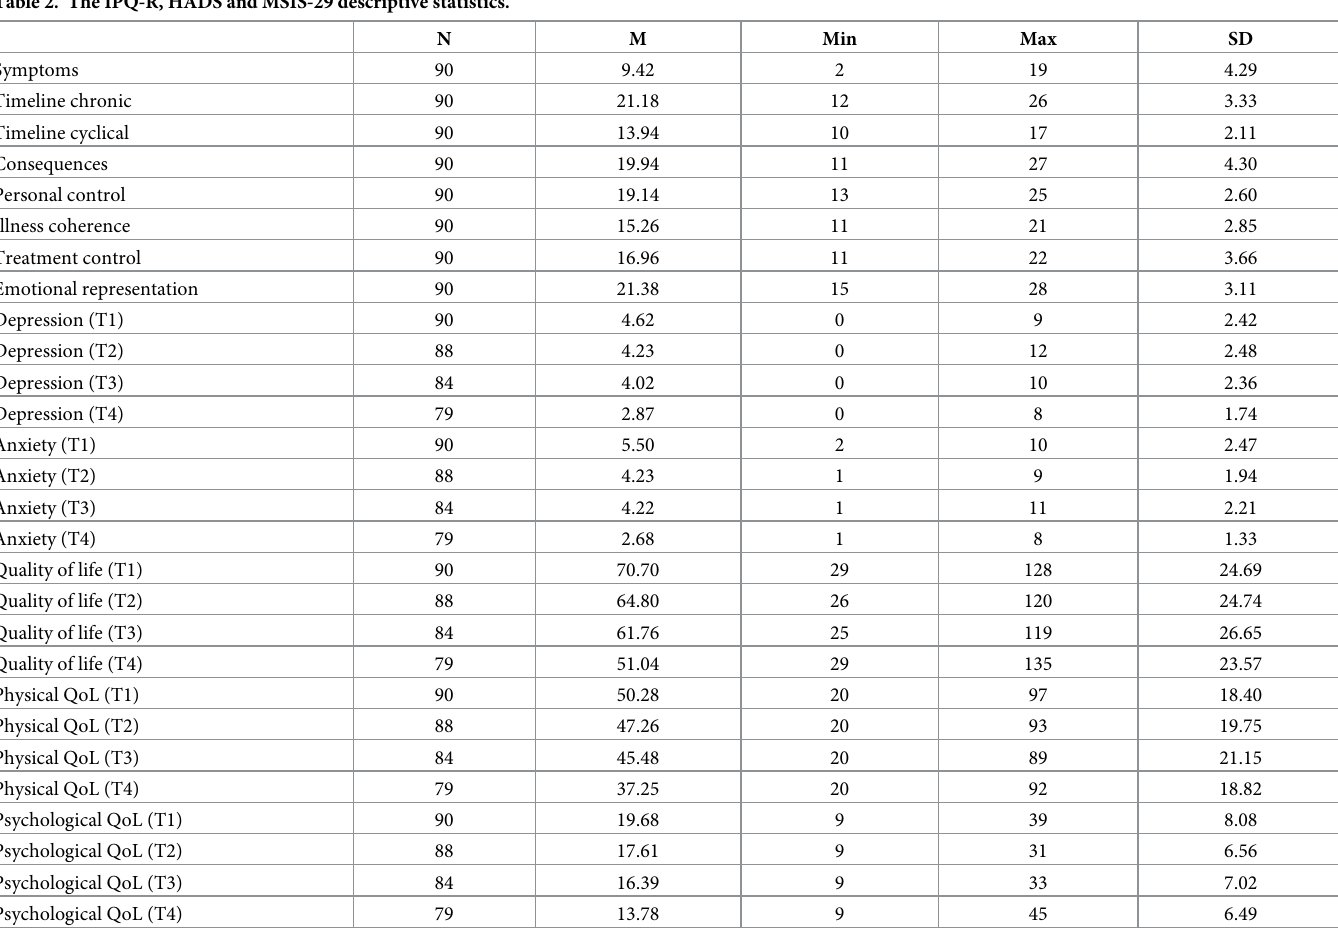
Table 2. The IPQ-R, HADS and MSIS-29 descriptive